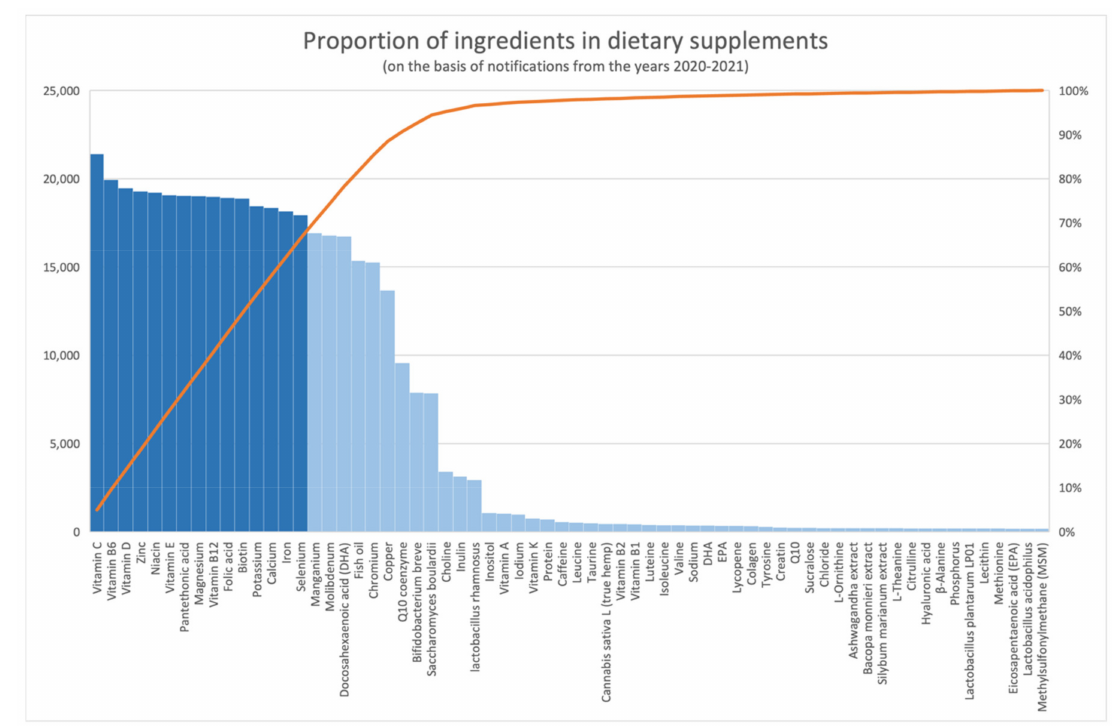
Figure 4. Proportion of ingredients in dietary supplements (based on entries from the period 1 January 2020–19 March